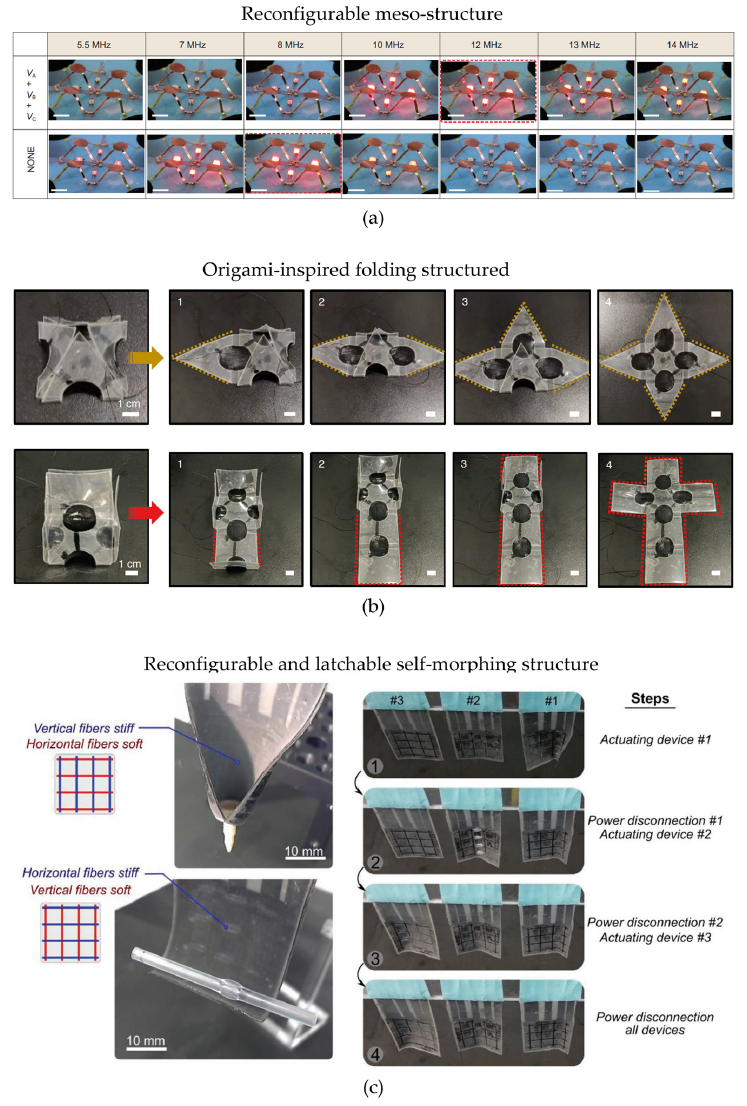
Figure 14. Examples of three ‐ dimensional DEA reconfigurable structures: ( a ) 3D reconfigurable meso ‐ structure [156]; ( b ) 3D origami ‐ inspired folding actuator [157]; ( c ) Reconfigurable and latcha